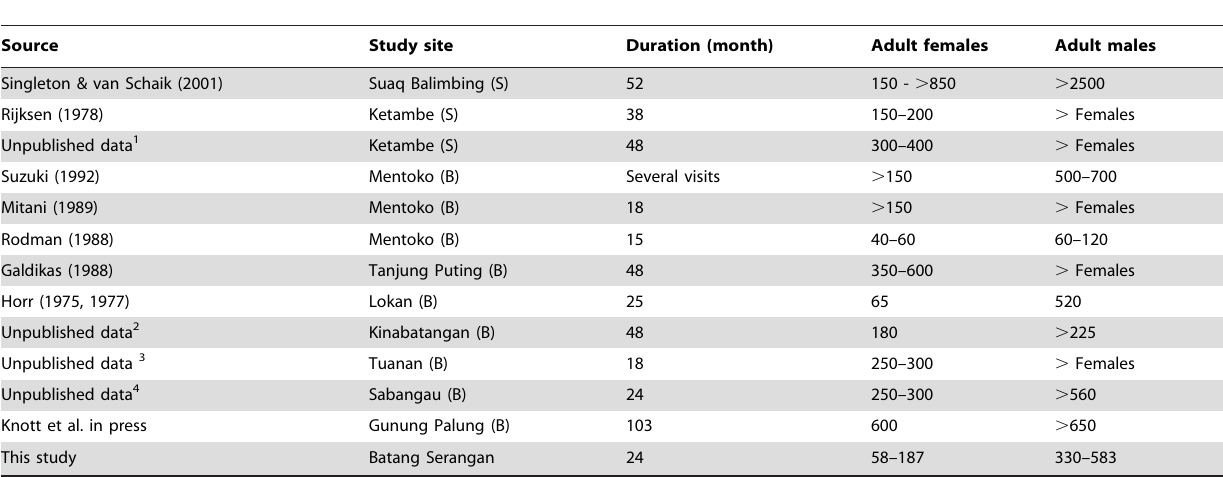
Data table adapted from Singelton et al., 2009 [52] and Utami et al., 2009 [34]. 1, Ketambe orangutan project Universitas Nasional Jakarta & Utrecht University Netherlands; 2, Ancrenaz and James; 3, Tuanan orangutan project Universitas Nasional Jakarta & University of Zu¨rich; 4, Morrogh-Bernard.